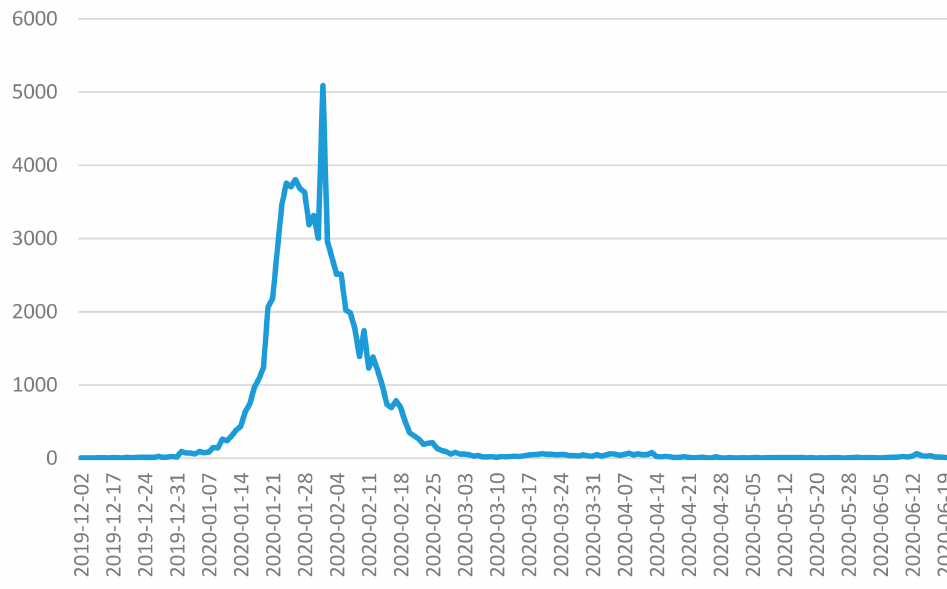
Figure 1. Daily number of COVID-19 cases in mainland China between 2 December 2019 and 20 June 2020 (dates of onset are used for the